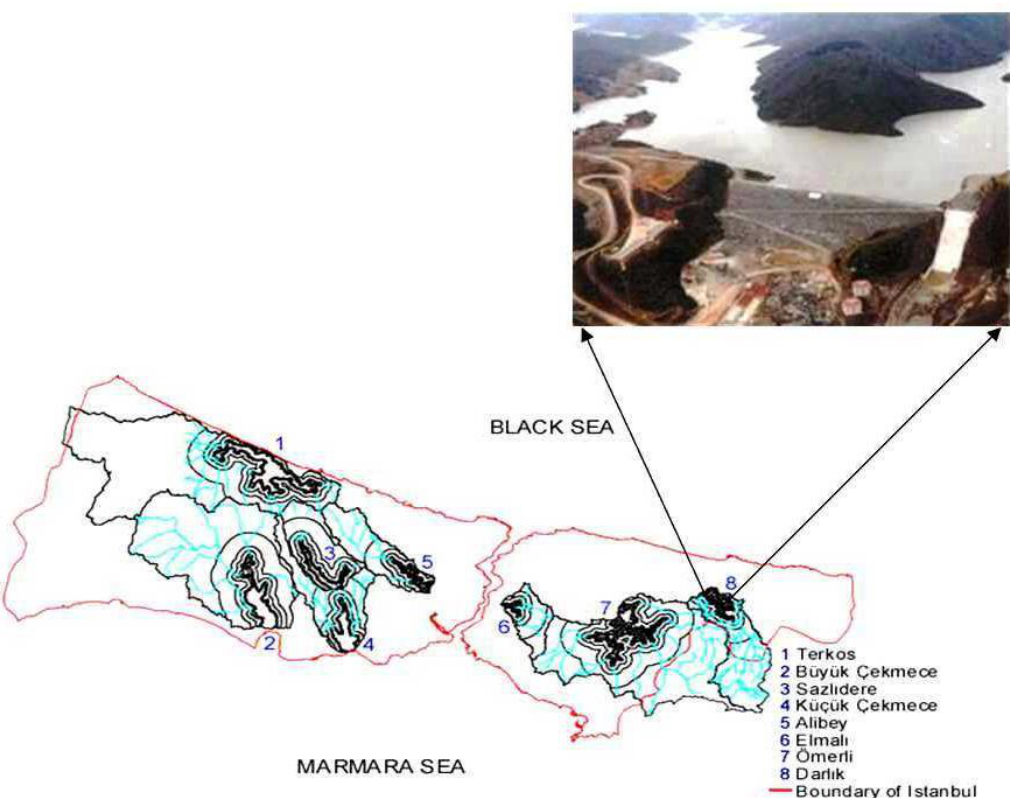
FIGURE 1. Location of Darlık and other reservoirs and their